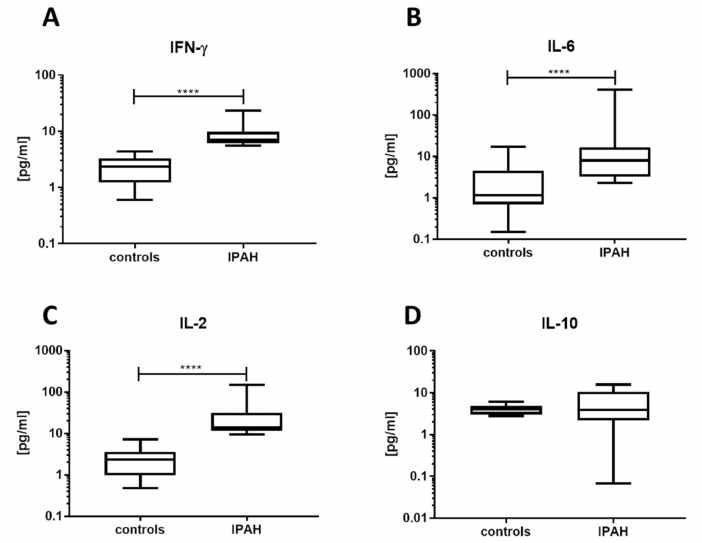
Figure 3. Levels of proinflammatory cytokines are increased in the IPAH patients’ plasma, while concentration of IL-10 remains unchanged. Plasma from IPAH patients and from healthy controls was assayed for ( A ) IFN- γ , ( B ) IL-6, ( C ) IL-2, and ( D ) IL-10. Levels of IFN- γ , IL-6, and IL-2 were highly increased in IPAH patients as compared to controls, and IL-10 was not statistically di ff erent between those two groups. Horizontal bars represent medians; boxes overlap 25th to 75th percentiles, and whiskers extend from minimum to maximum. Herein, **** denotes p ≤